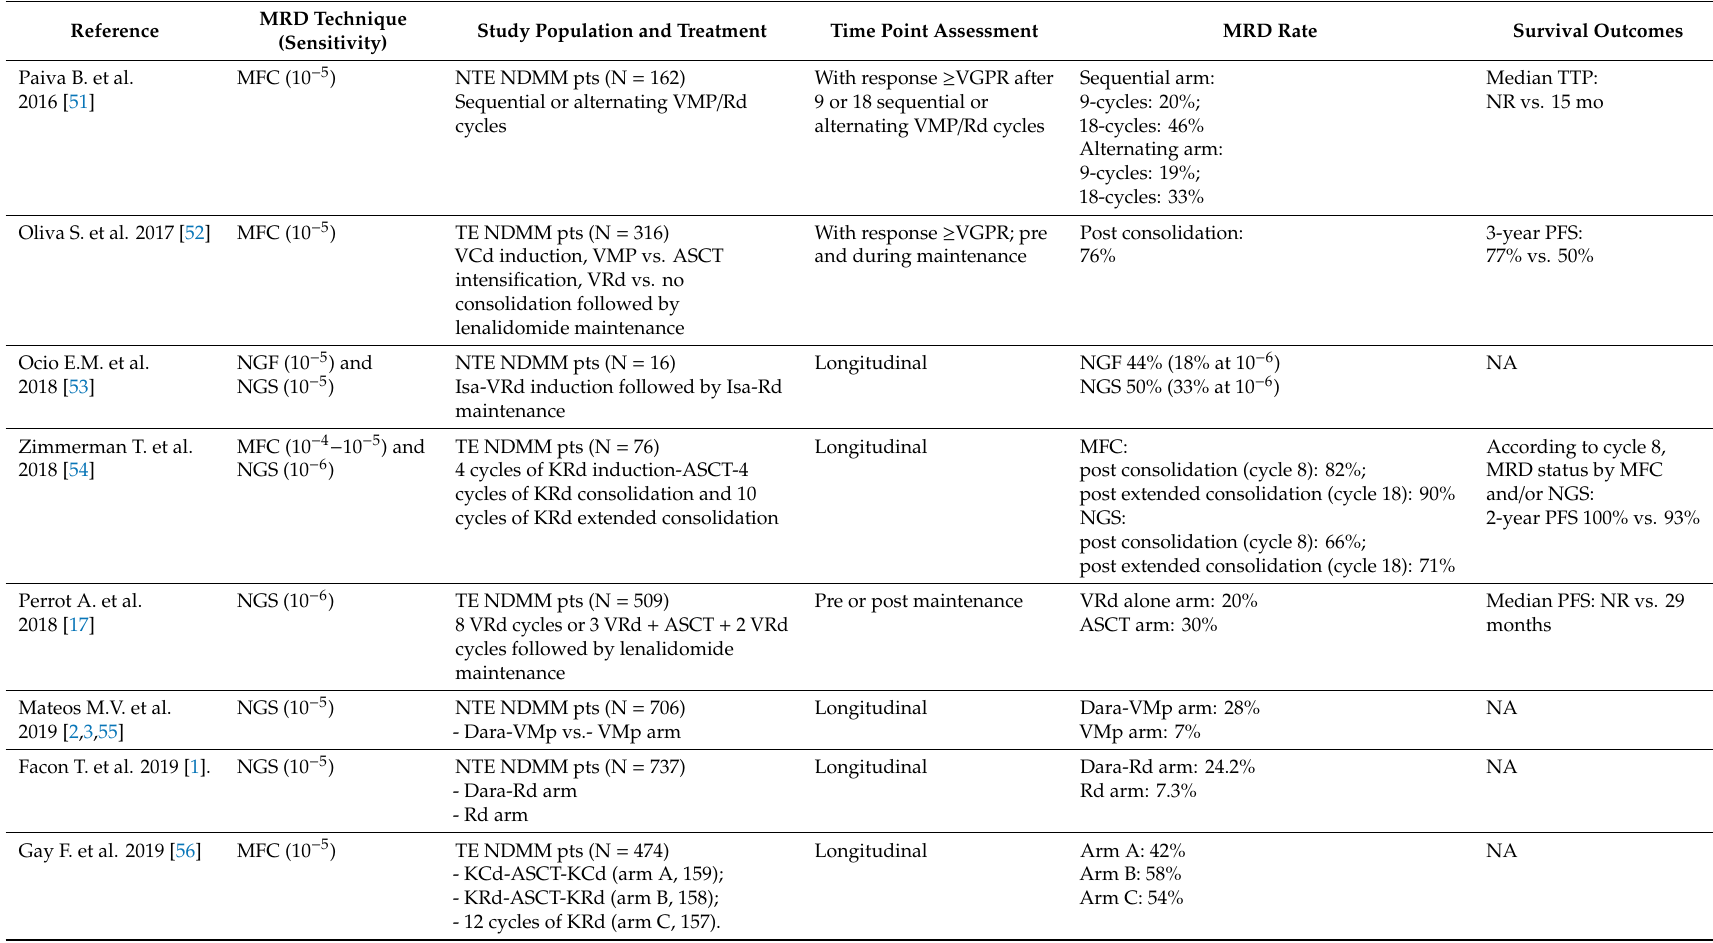
Table 2. NDMM patients treated with novel agents: latest selected studies with MRD